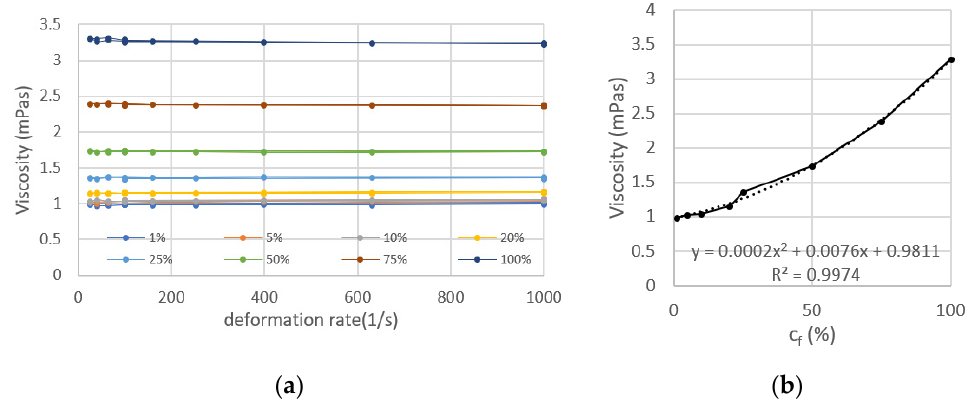
Figure 7. Characterization of the viscosity of the liquid generator. ( a ) For all the concentrations tested the viscosity has no dependence on the deformation rate (i.e., Newtonian liquid); ( b ) the viscosity bears a quadratic relationship to the surfactant concentration.